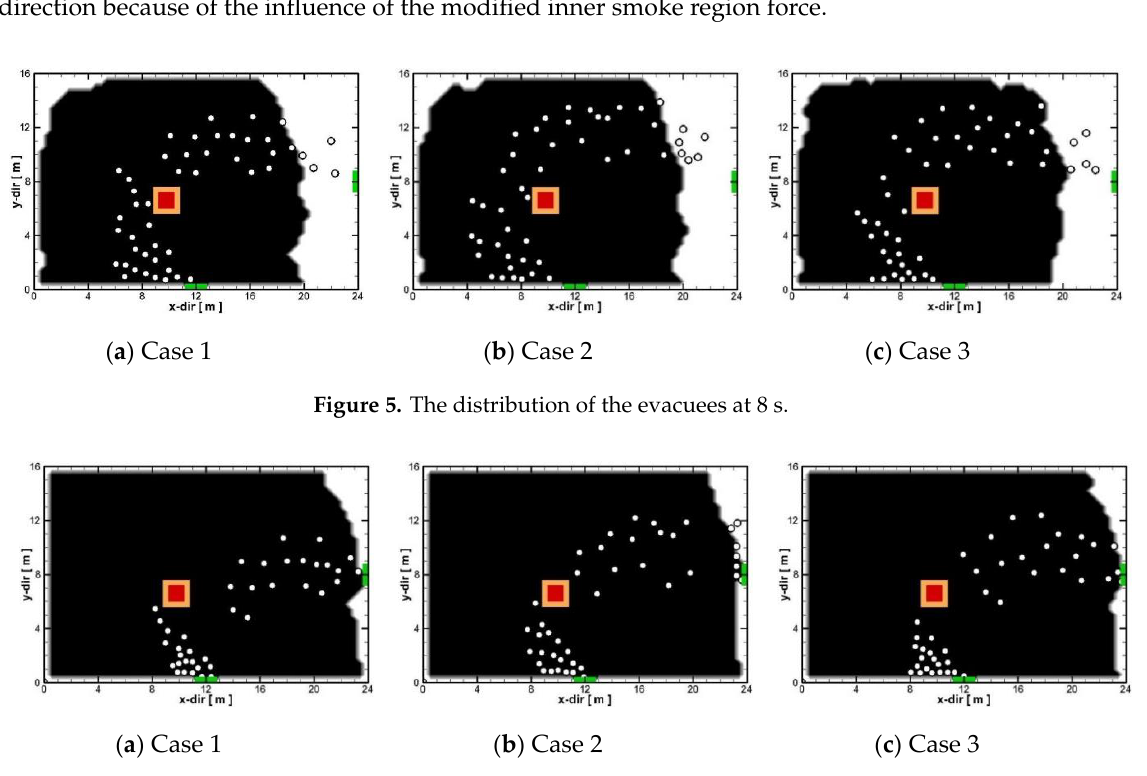
Figure 6. The distribution of the evacuees at 12 s.